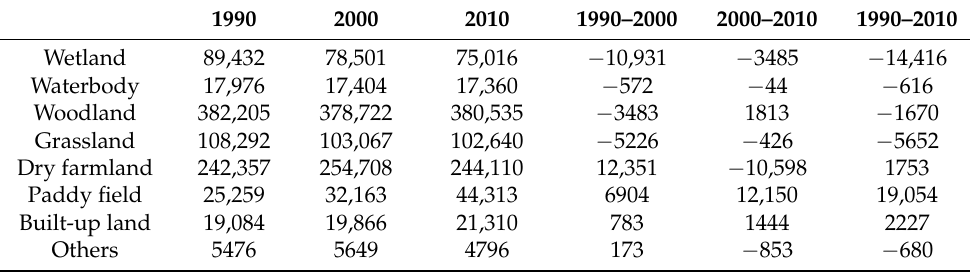
Table 5. Areal extents and changes of wetland and other land covers on the